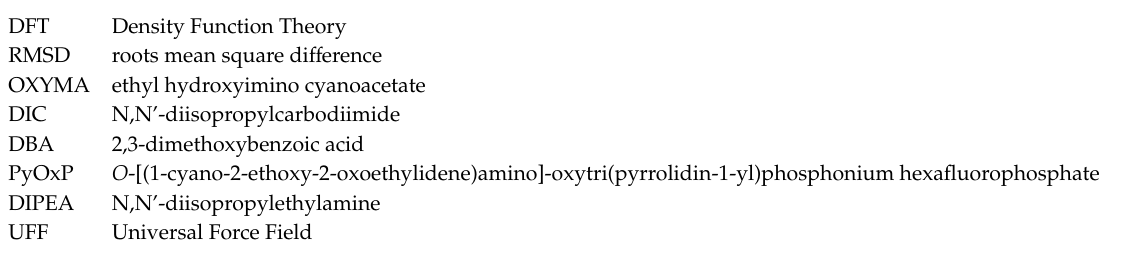
Figure S1: Structures and elemental compositions of tricatecholate-based peptide 1 and its protonated form (A); HPLC-DAD / 254nm (B), low res ESI + MS (C) and ESI + HRMS (D) (calculated m / z for [M + H] + = 684.2260; found = 684.2272), Figure S2: Structures and elemental compositions of tricatecholate-based peptide 2 and its protonated form (A); HPLC-DAD / 254nm (B), low res ESI + MS (C) and ESI + HRMS (D) (calculated m / z for [M + H] + = 768.3199; found = 768.3211), Figure S3: Structures and elemental compositions of tricatecholate-based peptide 3 and its 810.3668; found = 810.3691), Figure S4: 1 H NMR of tricatecholate-based peptide 1 (in CD 3 OD + D 2 O),